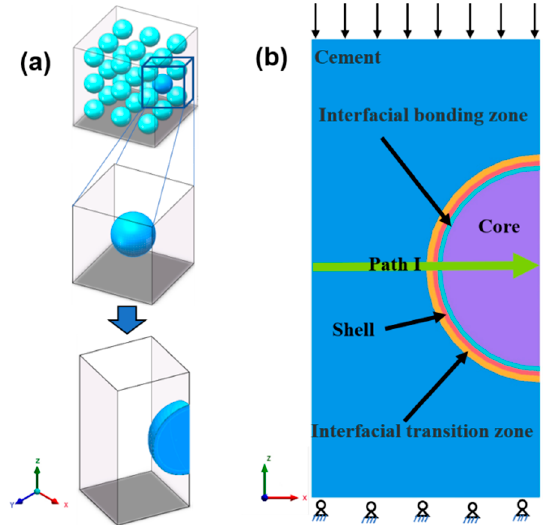
Figure 2. ( a ) Unit-cell model of core–shell lightweight aggregate concrete and ( b ) Schematic showing the model used in this study.